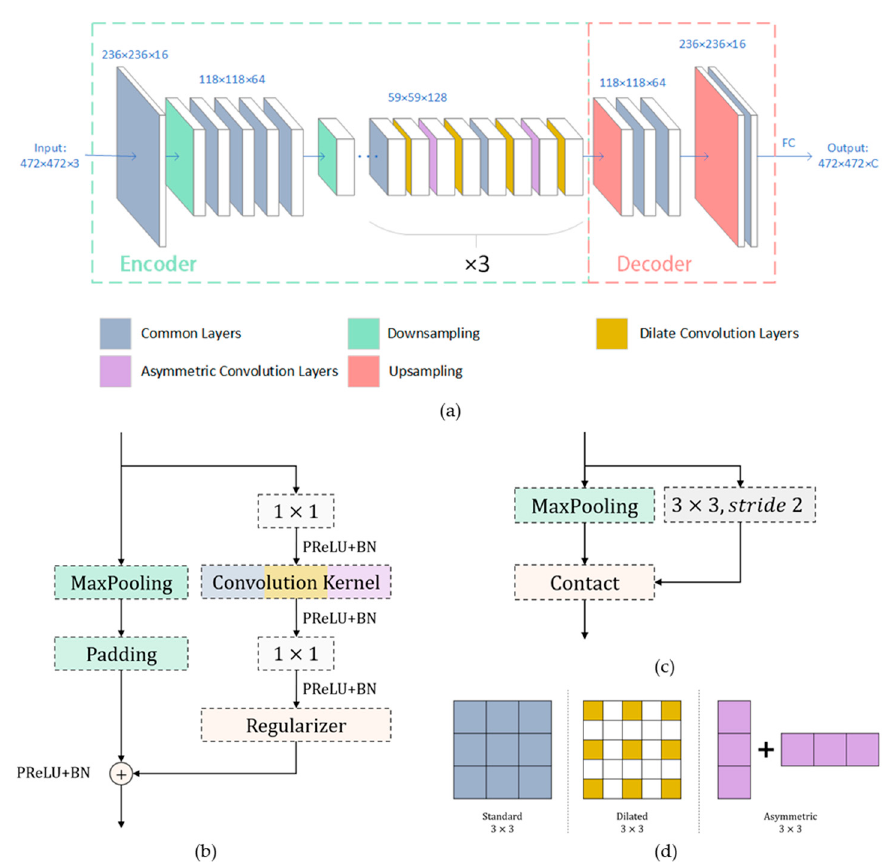
Figure 4. The framework of semantic segmentation network [29]. ( a ) Convolutional network main framework. ( b ) Bottleneck layers inner structure. ( c ) Initial layer. ( d ) Three kinds of convolution kernels: standard, dilated, and asymmetric kernels.